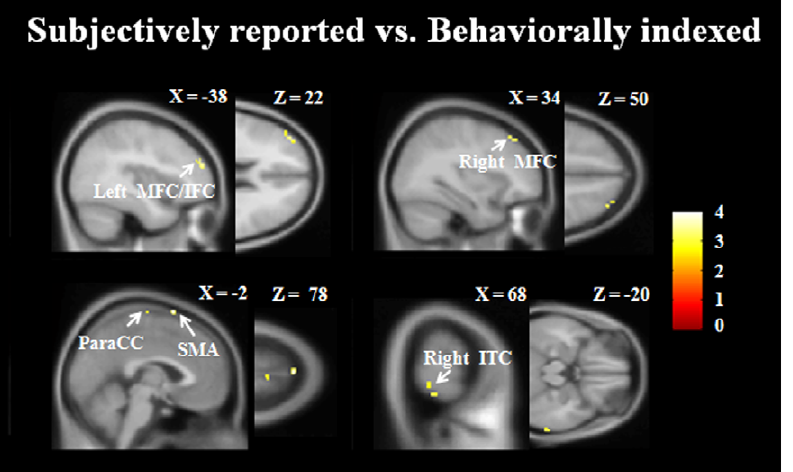
Figure 3. Gamma band beamformer analysis showed increased neural activity associated with subjective reported mind wandering relative to behavioral indexed mind wandering. The results were superimposed on a group-averaged T1 MRI image. X/Y/Z are MNI coordinates. MFC=middle frontal cortex; IFC=inferior frontal cortex; SMA=supplemental motor area; ParaCC=paracentral cortex; ITC=inferior temporal